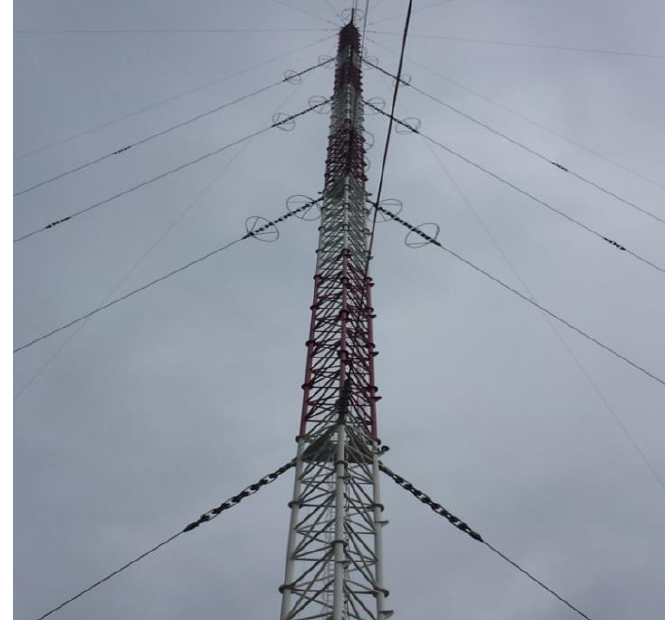
Figure 2. Single umbrella antenna of Changhe II.